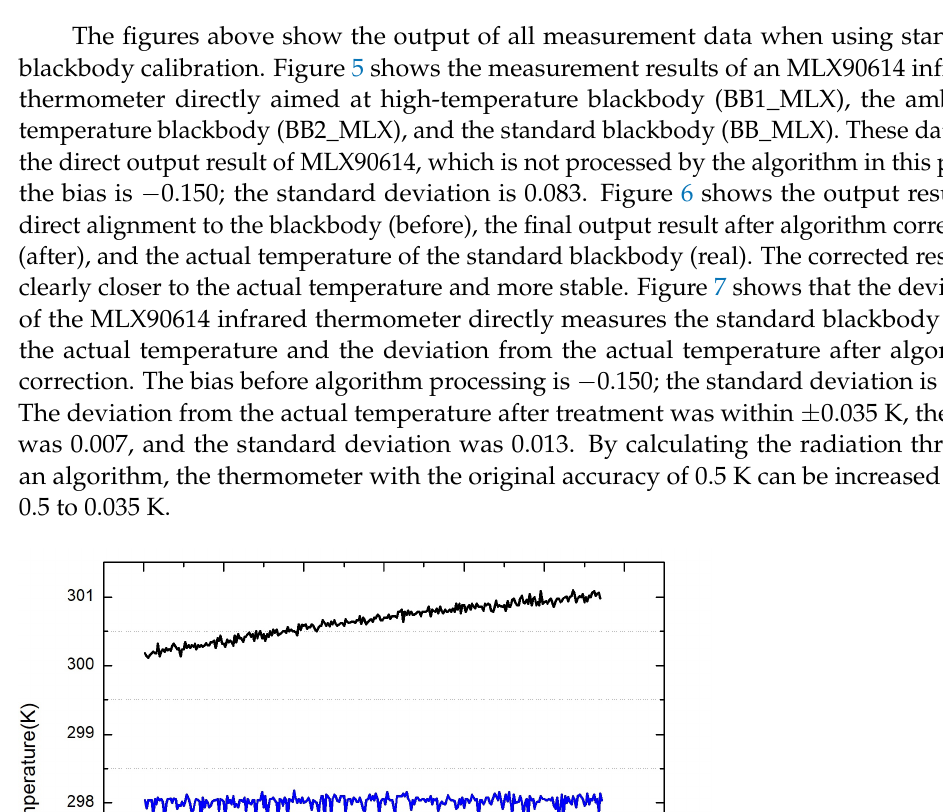
Figure 4. Optical path of equipment: high-temperature blackbody, ambient-temperature blackbody, target water surface, and infrared thermometer.